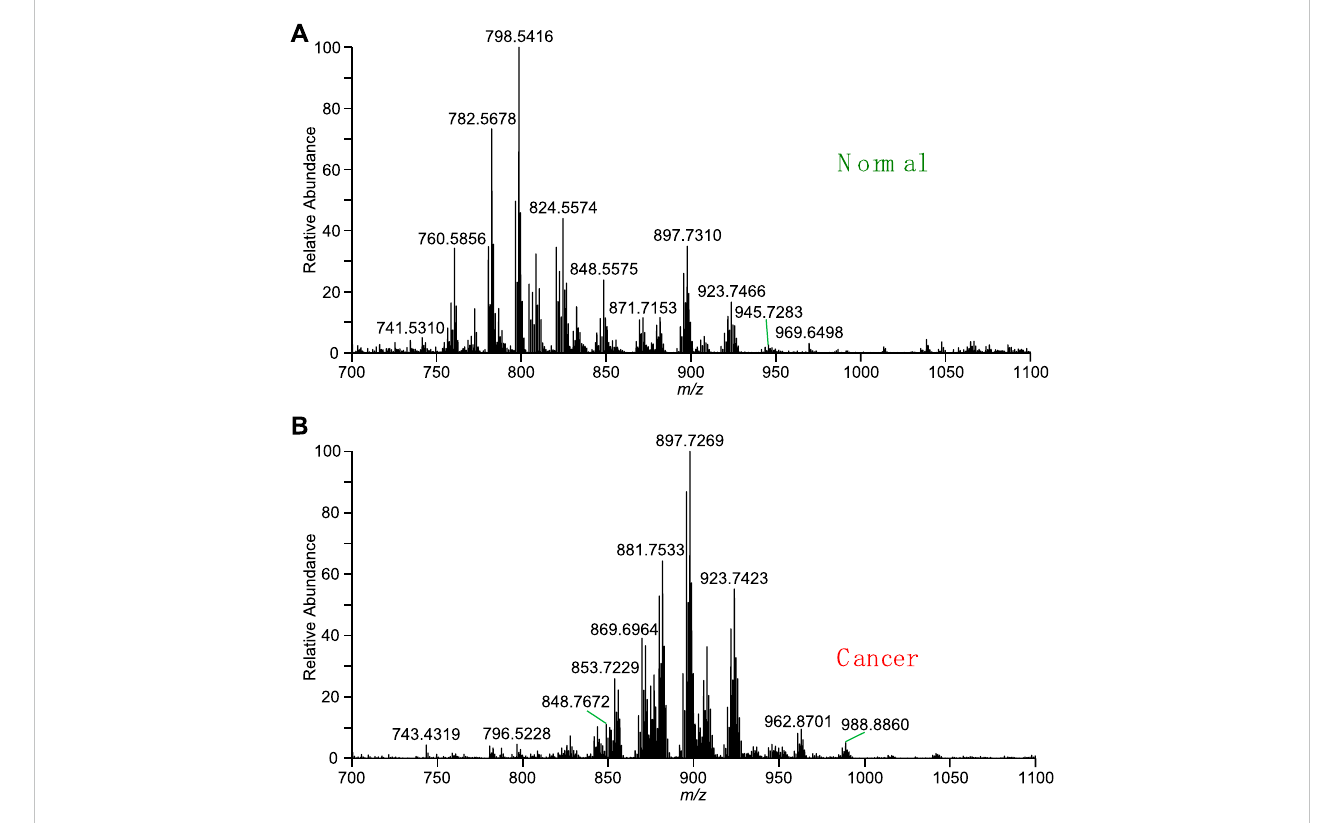
FIGURE 2 Mass spectra obtained by direct tissue analysis using WT-ESI-MS: (A) normal thyroid tissue, (B) cancer thyroid